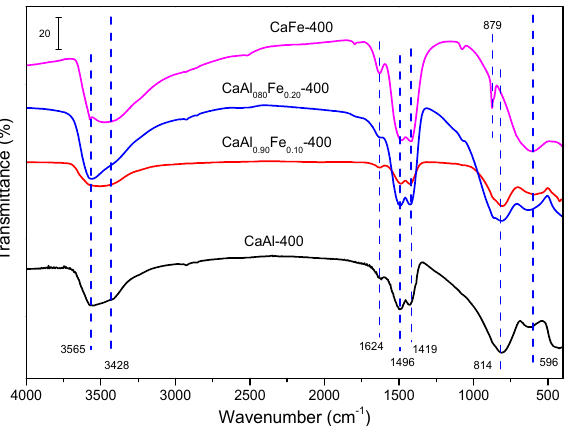
Figure 7. FT–IR spectra of the samples calcined at 400 °C.